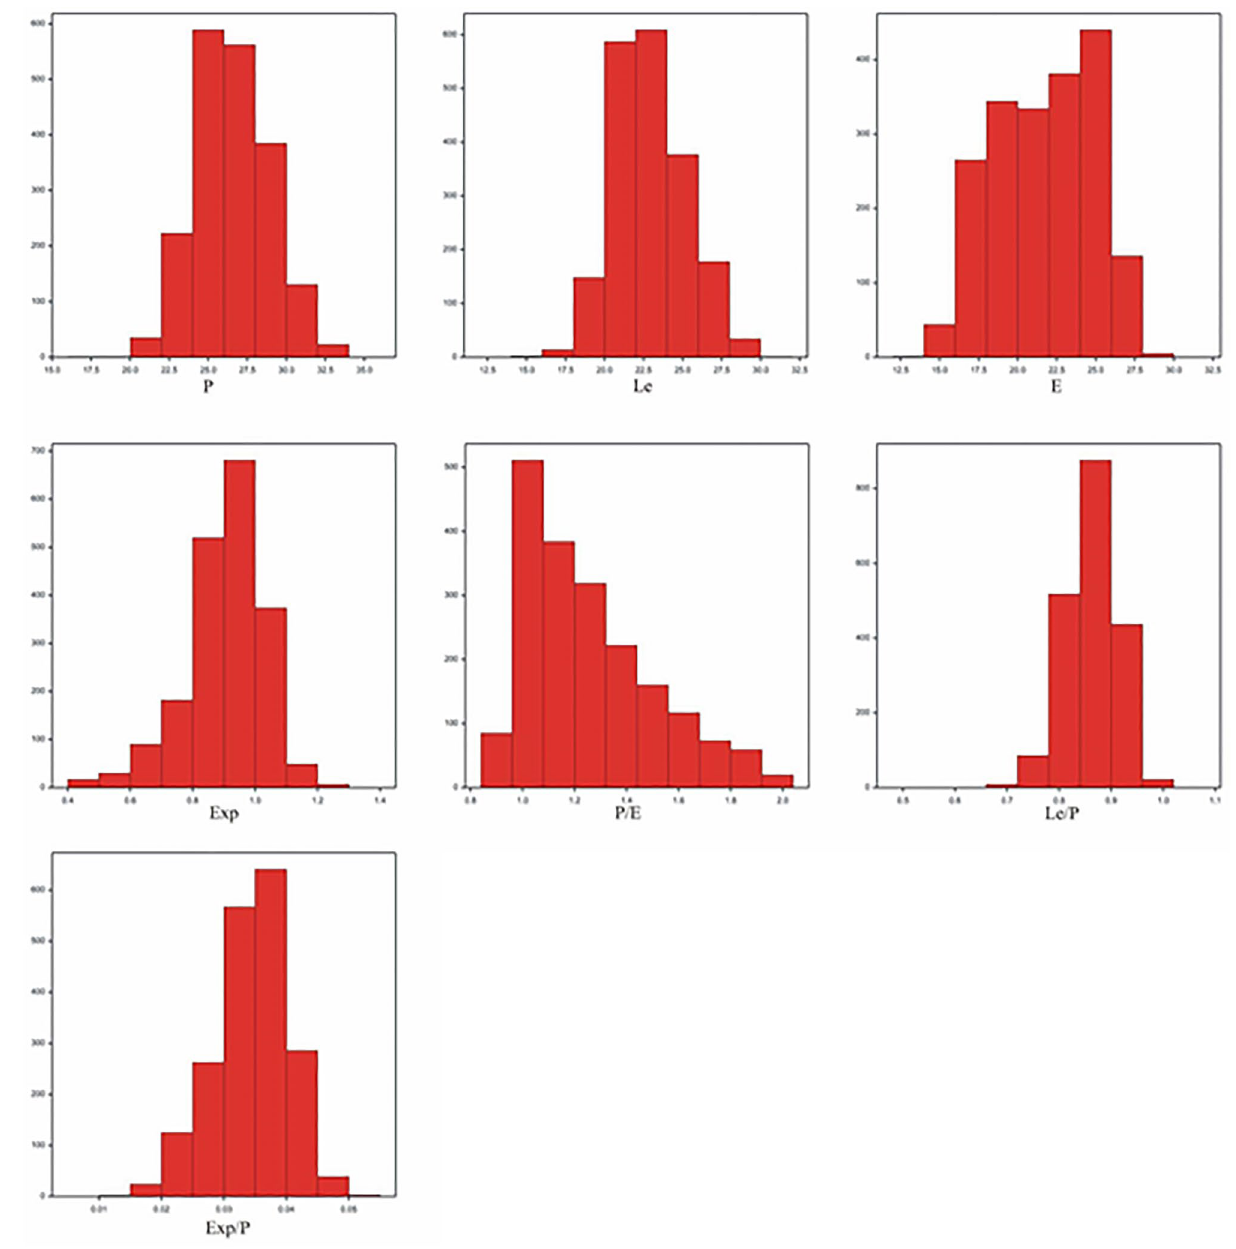
Figure 5. The empirical distribution of observations of the seven observed features. P – length of polar axis, E – equatorial diameter, Le – length of ectocolpus, Exp – thickness of exine along the polar axis.